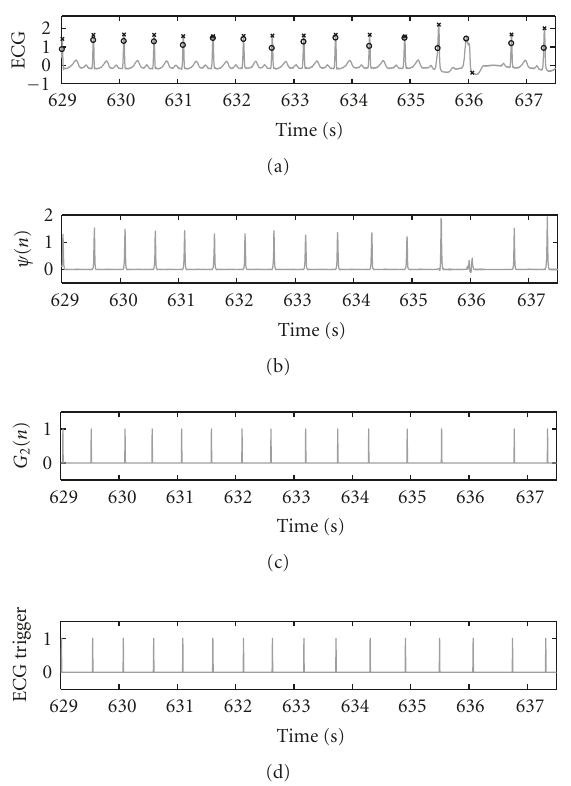
Figure 12: Generation of the ECG trigger on recording n ◦ 208 of the MIT/BIH database: (a) ECG with the reference annotation indicated by “o” and the automatic detection indicated by “x”, (b) and (c) intermediate stages of the R -peak detection procedure (see main text for details on these signals) and (d) ECG trigger.